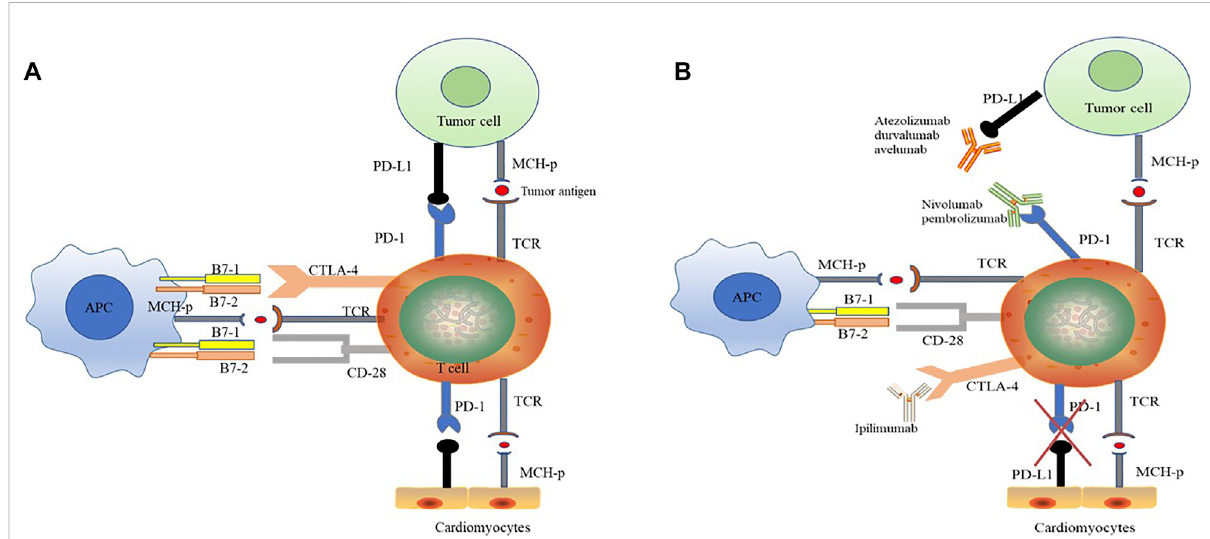
The anti-tumor effect of ICI therapy is associated with potential cardiotoxicity. (A) “ PD-1 – PD-L1 axis ” induced immunosuppression. PD-1 is a member of the CD28 superfamily. PD-1 inhibits the activation of T cell receptor-proximal kinases and prevents the formation of stable T cell-APC contacts, thereby affects signal transduction and cell-effective functions mediated by T cell antigen receptors. PD-1 ligands (PD-L1 and PD-L2) are highly expressed in tumor cells, and the PD-1 expression of in fi ltrating T cells is upregulated under tumor microenvironment. PD-1 and PD-L1 combination suppresses T cell activation and disables the anti-tumor immune response. Meantime, PD-L1 is also expressed in cardiomyocytes, and the binding of PD-1 to myocardial PD-L1 suppresses the own immune response and maintains the homeostasis in heart. (B) ICIs have anti-tumor effects and potential cardiotoxicity. ICIs are neutralizing antibodies that completely bind to immunosuppressive checkpoints and thus exerts anti- tumor by activating immune response. PD-1 antibody (Atezolizumab, durvalumab and avelumab) and PD-L1 antibody (Nivolumab and pembrolizumab) respectively binding to PD-1 and PD-L1, breaking “ PD-1 – PD-L1 axis ” between immune and tumor cells. CTLA-4 has a stronger af fi nity for B7-1 and B7-2 than CD28. CTLA-4 inhibitor (Ipilimumab) broadly enhances the immune response dependent on CD4 + cells. Otherwise, during ICI treatments, the “ PD-1 – PD-L1 axis ” between immune cell and cardiomyocytes is also hindered, resulting excessive activation of immune response and cardiotoxicity. CTL-4, cytotoxic T lymphocyte-associated protein-4; TCR, T cell receptor; PD-1, programmed cell death protein-1; PDL-1, programmed cell death